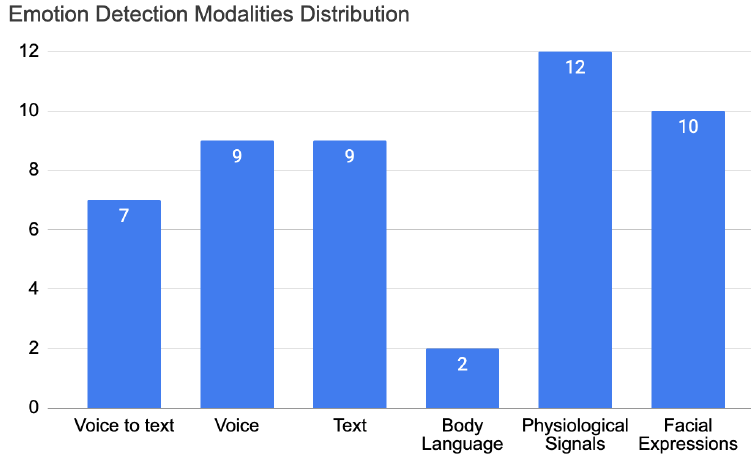
Figure 6. Distribution of articles over the detection modalities.